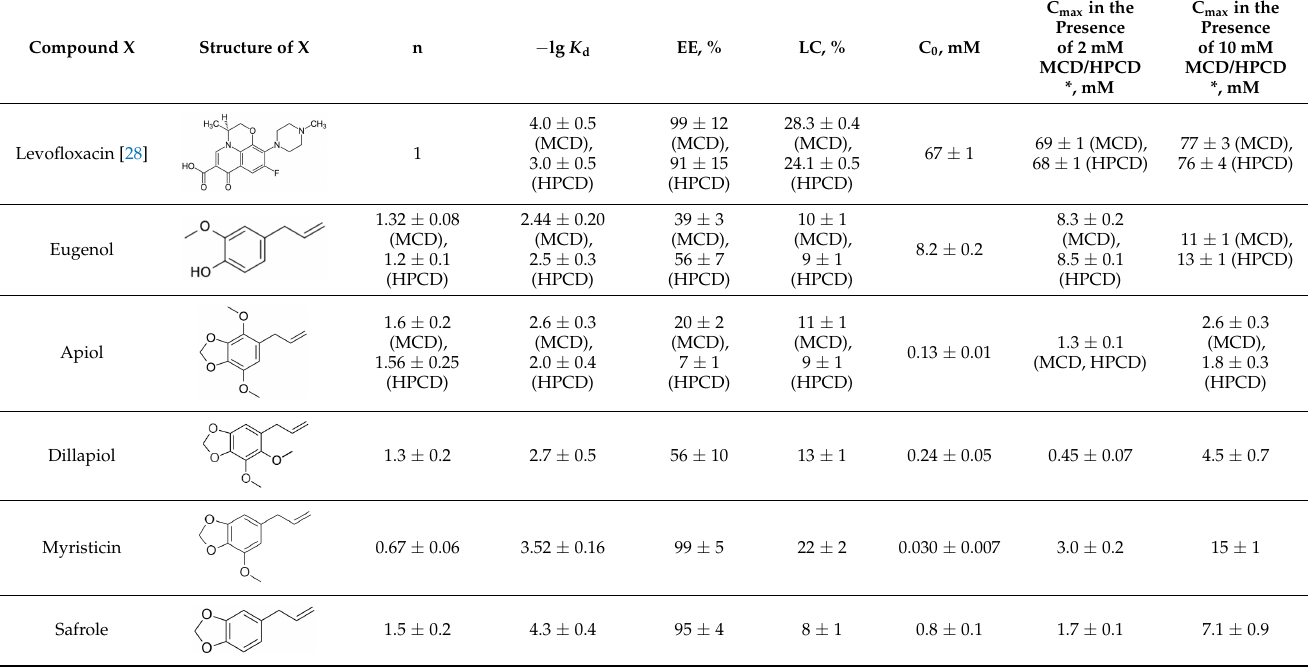
is important for a significant increase in the solubility of these compounds in water (Table